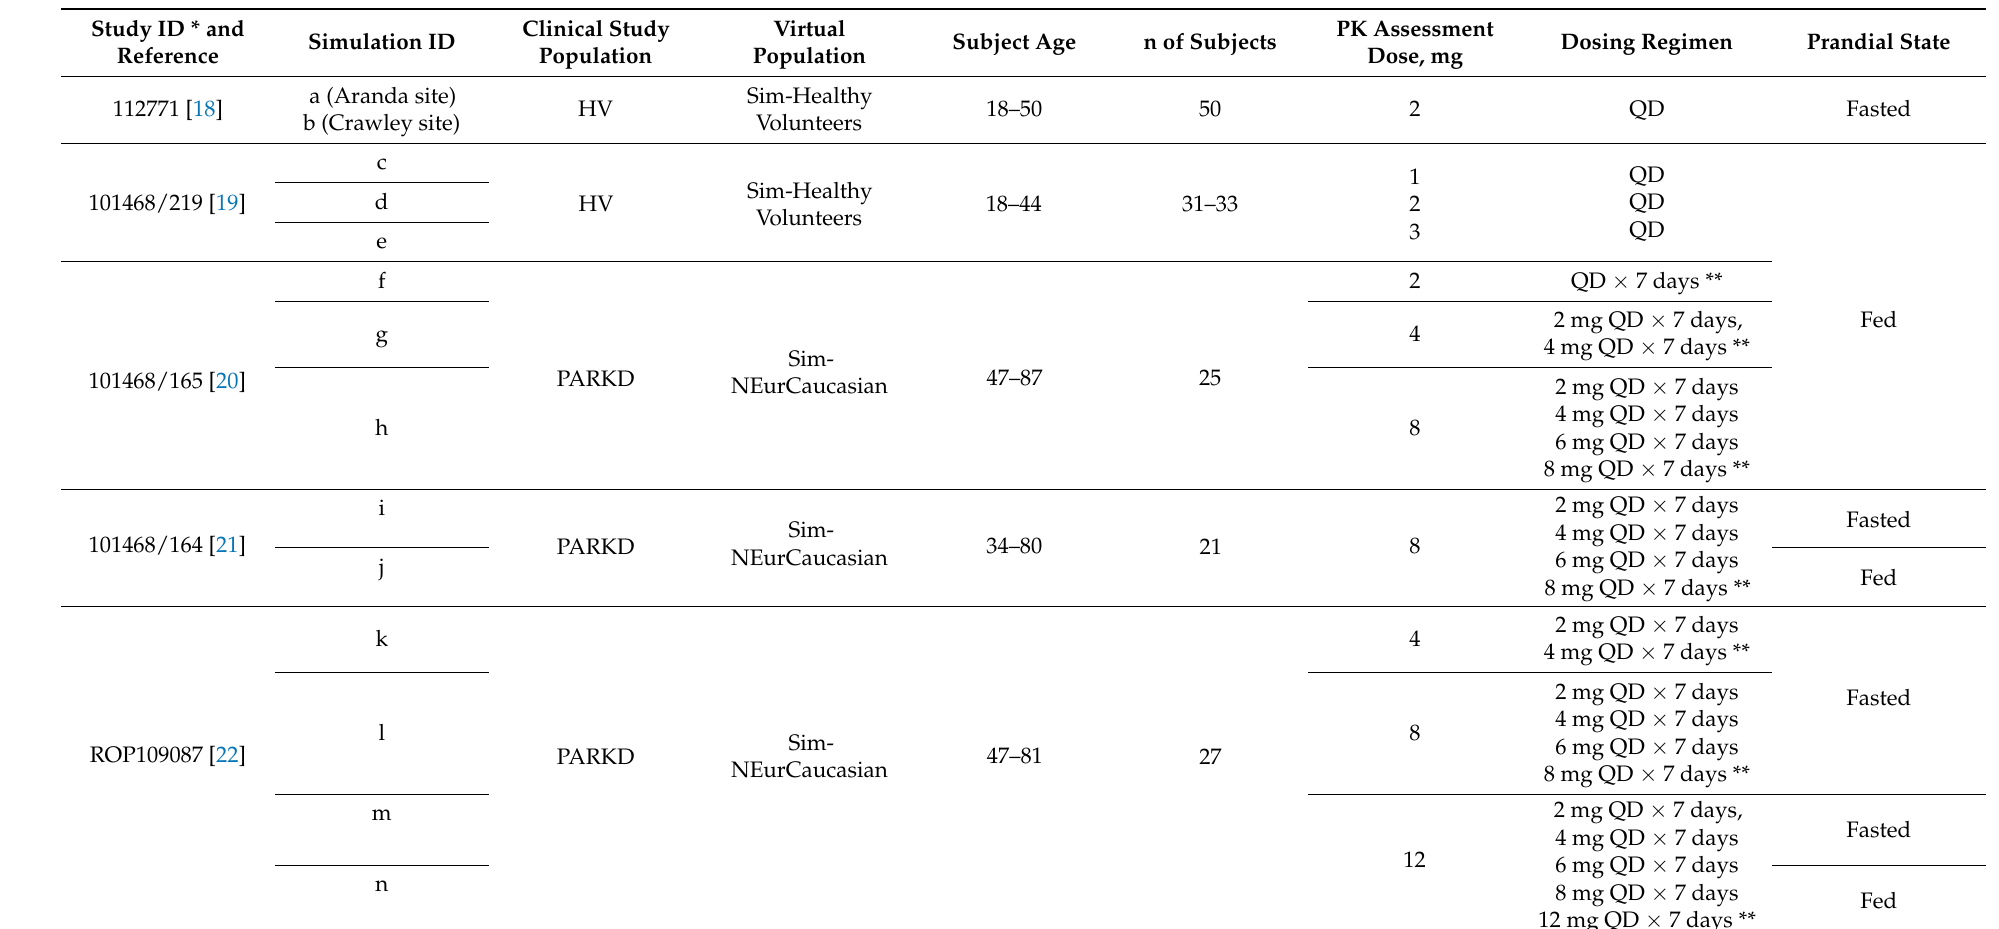
Table 2. Summary of the clinical trial design used in the